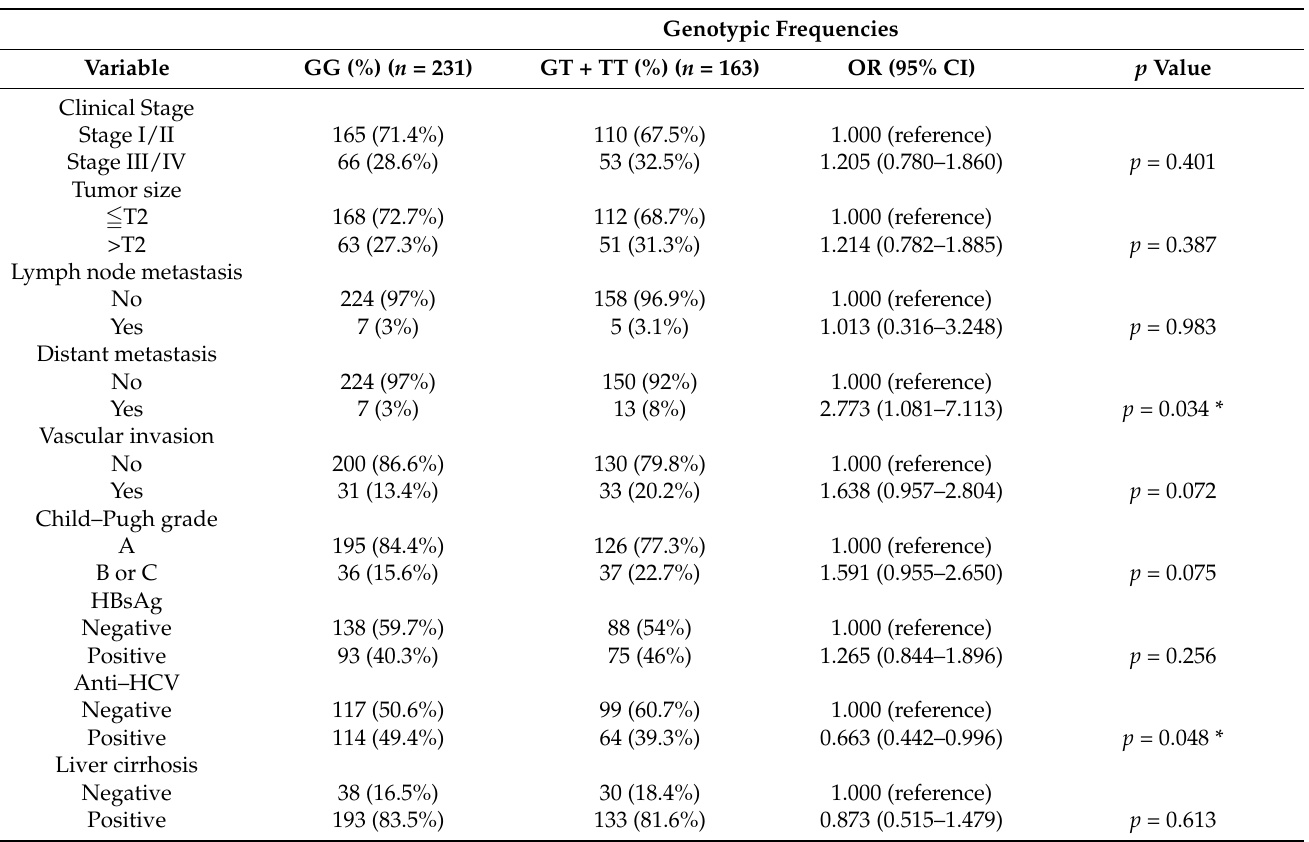
Table 5. Odds ratio (OR) and 95% confidence interval (CI) of clinical status and TRIM21 rs4144331 genotypic frequencies in HCC